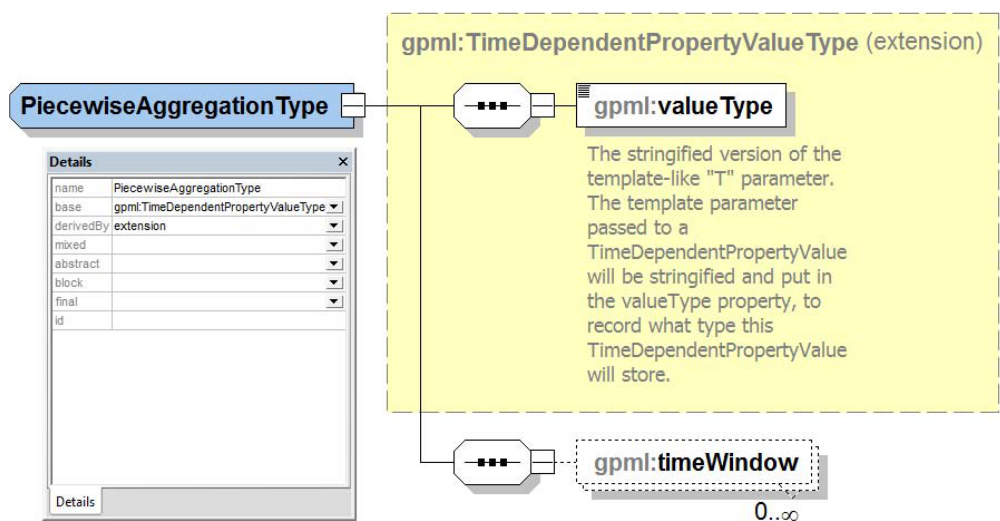
Fig. 14. The irregular sampling value schema diagram in GPML.